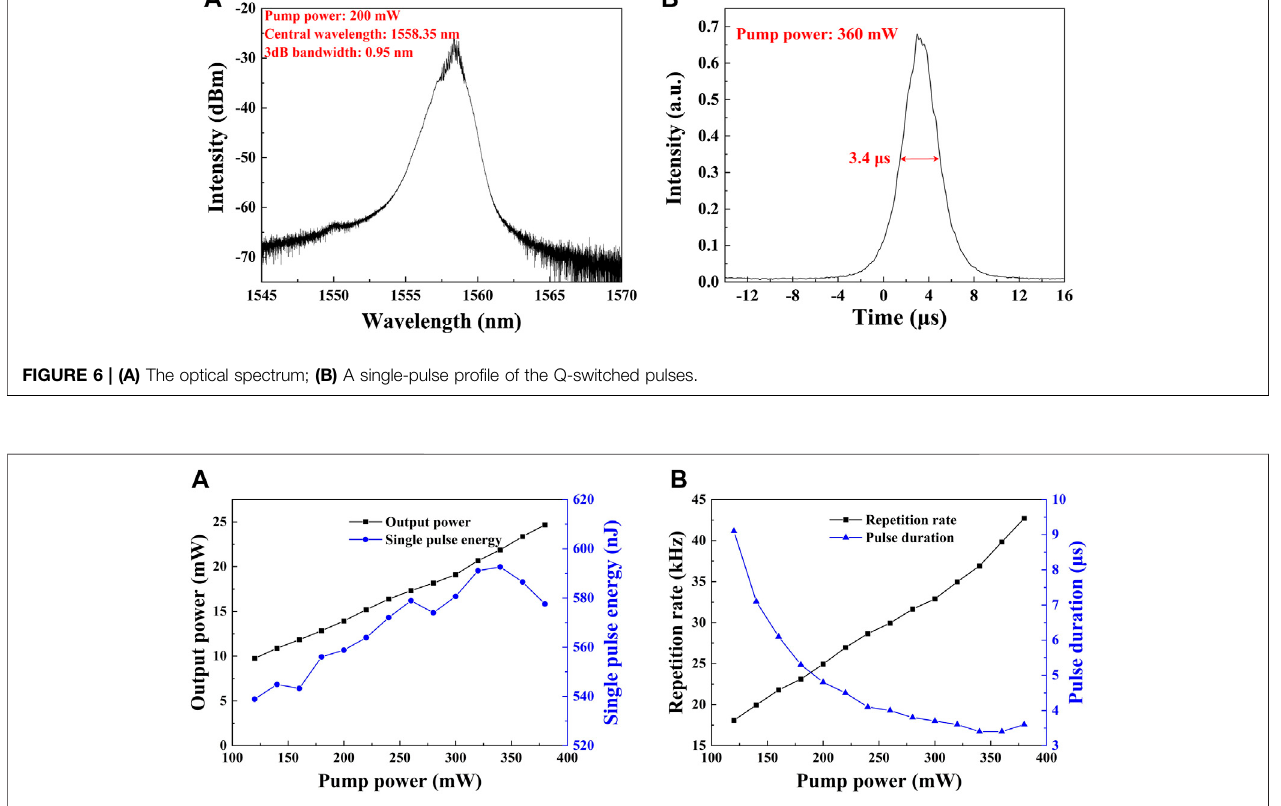
FIGURE 7 | The evolution of (A) average output power and single pulse energy, (B) repetition rate and pulse duration as pump power